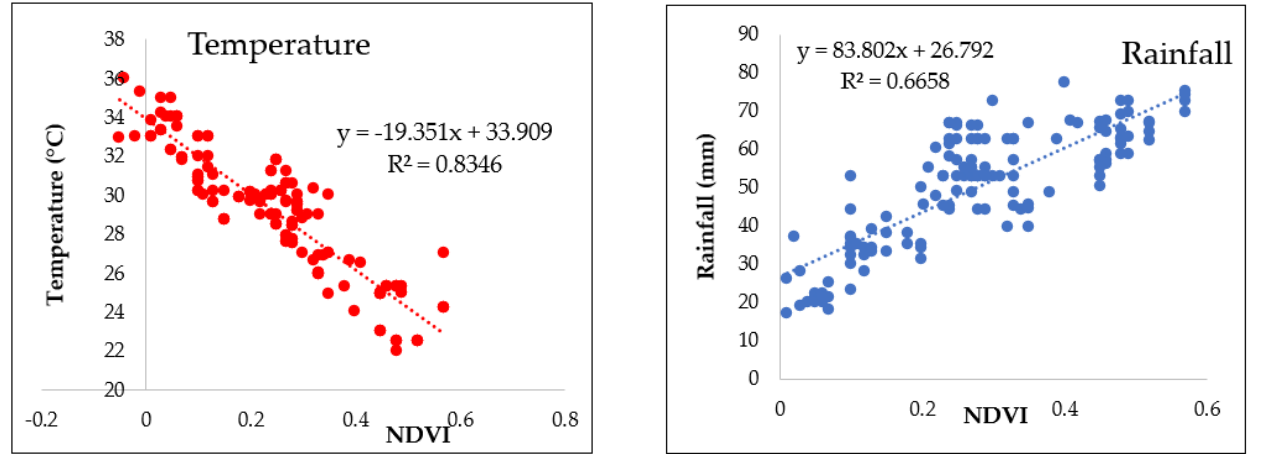
Figure 13. Relationship between NDVI with temperature and rainfall.